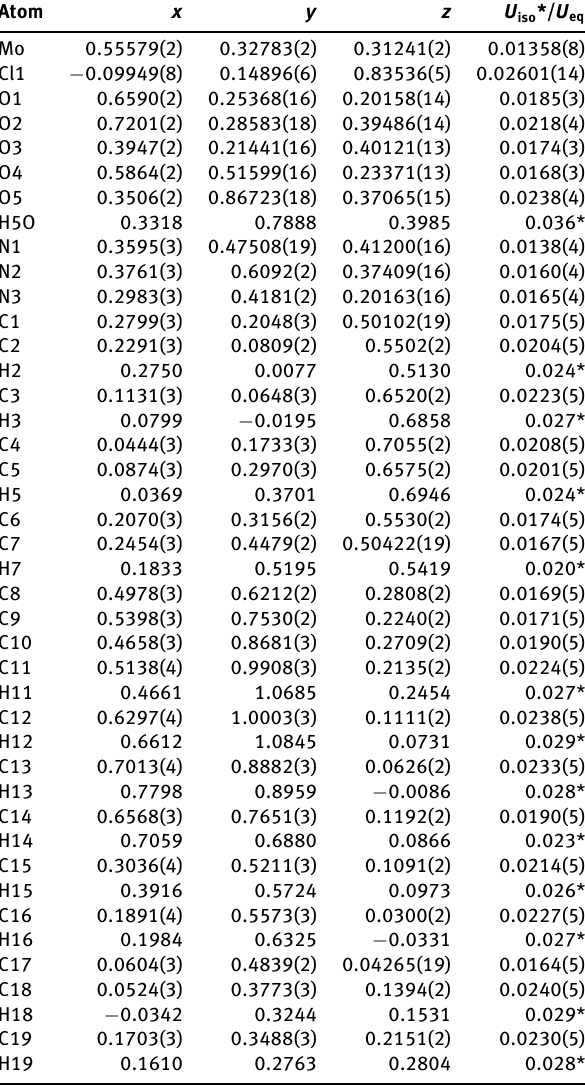
Table 2: Fractional atomic coordinates and isotropic or equivalent isotropic displacement parameters (Å 2